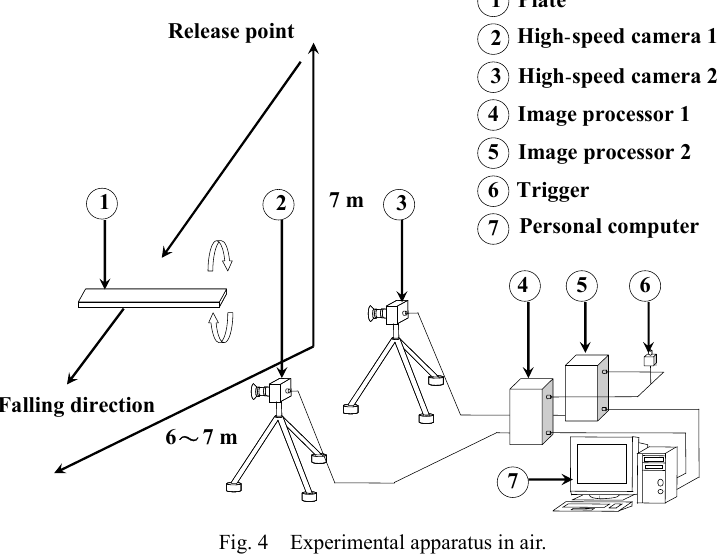
Fig. 4 Experimental apparatus in air.